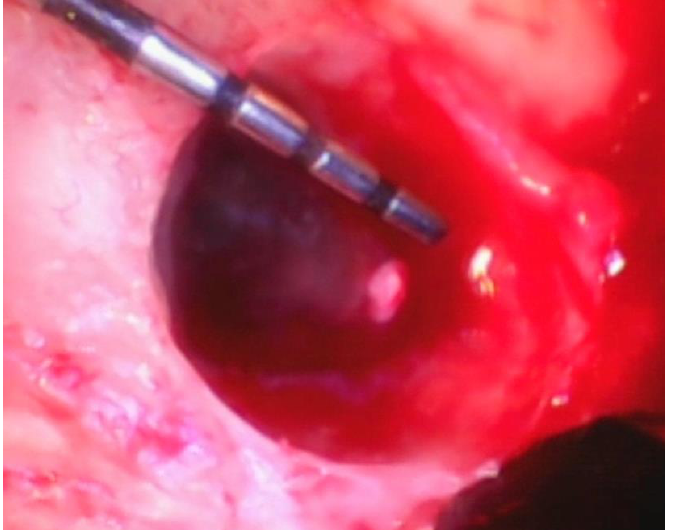
Figure 10. Videoscope visualization of the apex of a maxillary incisor during surgical endodontic treatment.